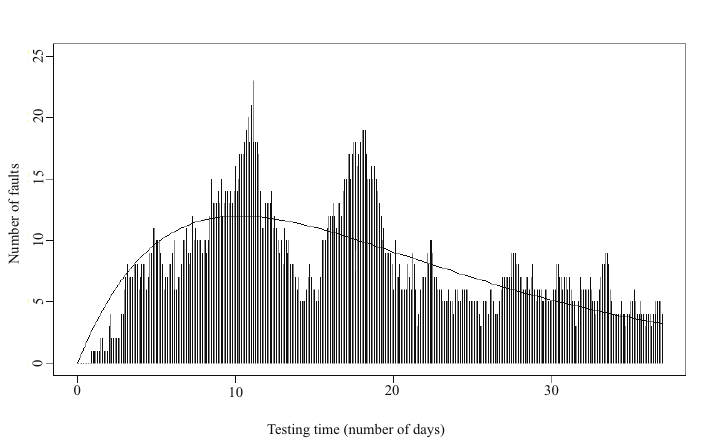
Figure 8. Behavior of the number of faults being corrected (the correction time is 1.0 day/fault on average, DSS data).